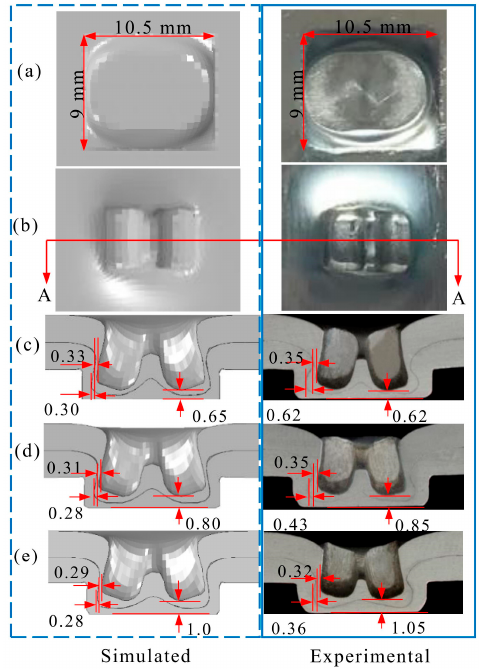
Figure 14. Comparison of the final formed joint shape of simulation and experiment: ( a ) on the die side, ( b ) on the rotated head side and in middle section of XZ of ( c ) group 15, ( d ) group 24 and ( e ) group 29.